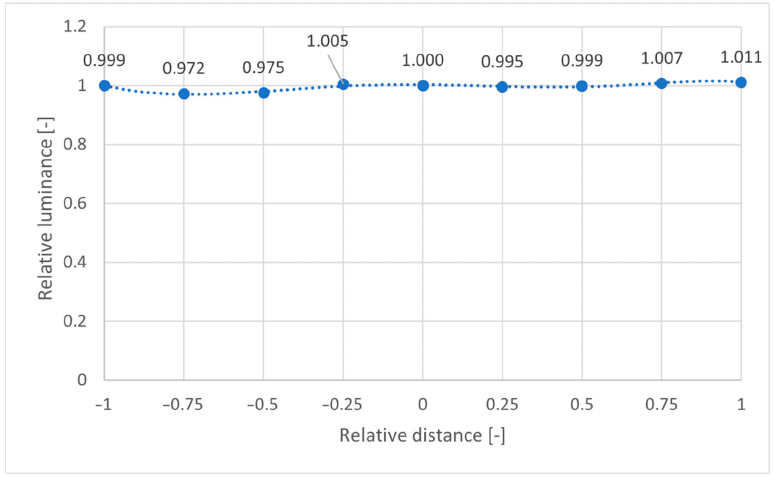
Figure 8. Lens shading effect post-assessment: relative distance 0 = centre of the image, relative distance 1 = corner of the image.